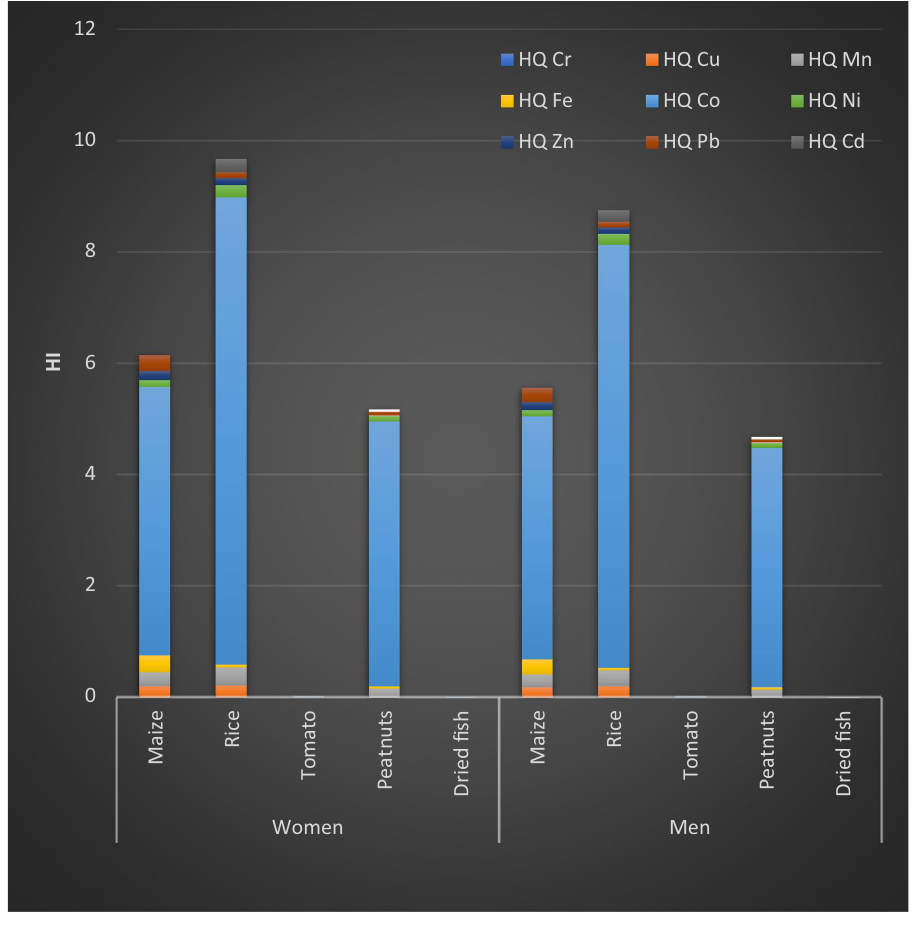
Figure 1. Non-cancer risk